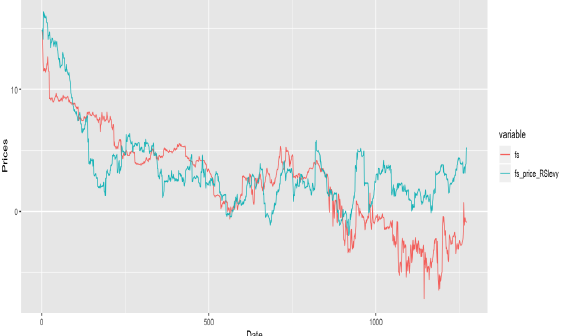
Figure 6. Simulation Result of RSLDOU model on fuel-switching data.